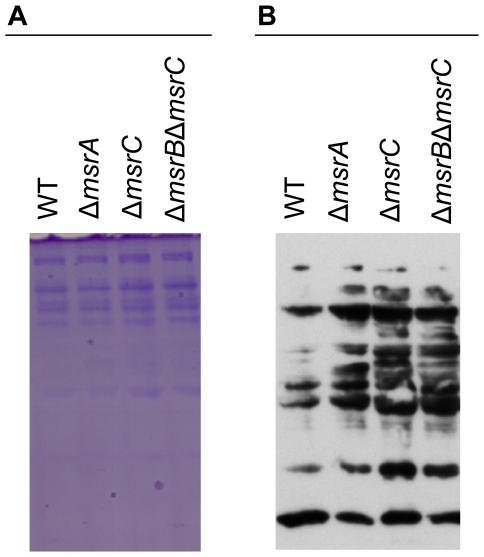
Oxyblot of whole cell extracts of S. Typhimurium wild type, ΔmsrA, ΔmsrC, ΔmsrBΔmsrC.Cells grown to OD600 1 were incubated in 0.75 mM H2O2 for 3 h. A. SDS-PAGE stained with Coomassie. B. Oxyblot film exposed for 2 min.